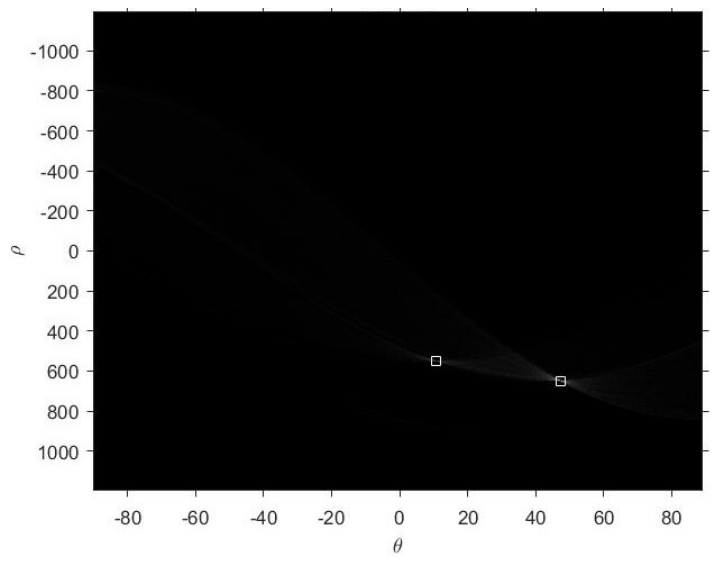
Figure 12. Dilation, combined with Zhang–Suen algorithm, corresponding to the Hough space.